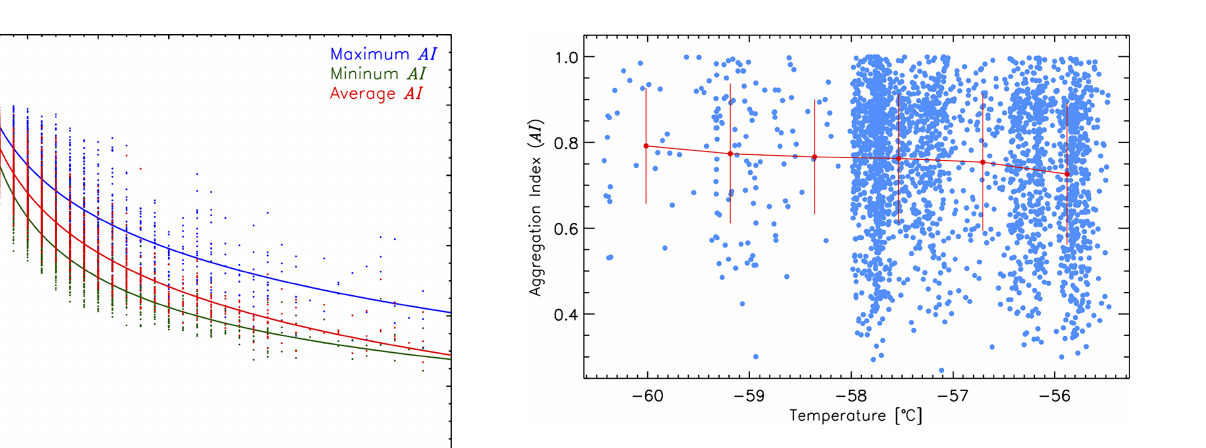
Figure 9. The average aggregation index (AI, red circles in Fig. 8) as a function of temperature (blue circles). The mean and standard deviation of AI for six temperature ranges are indicated by the red circles and vertical bars,